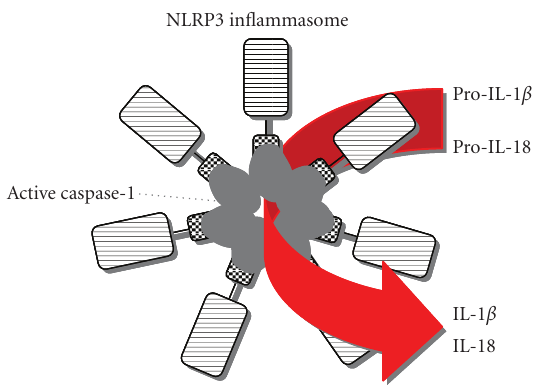
Figure 2: A possible schema for IL-18/IL-1 β processing by the inflammasome. After appropriate stimulation, the NLRP3 inflam- masome is activated to induce active caspase-1, which eventually results in conversion of pro-IL-18/pro-IL-1 β into biologically active IL-18/IL-1 β